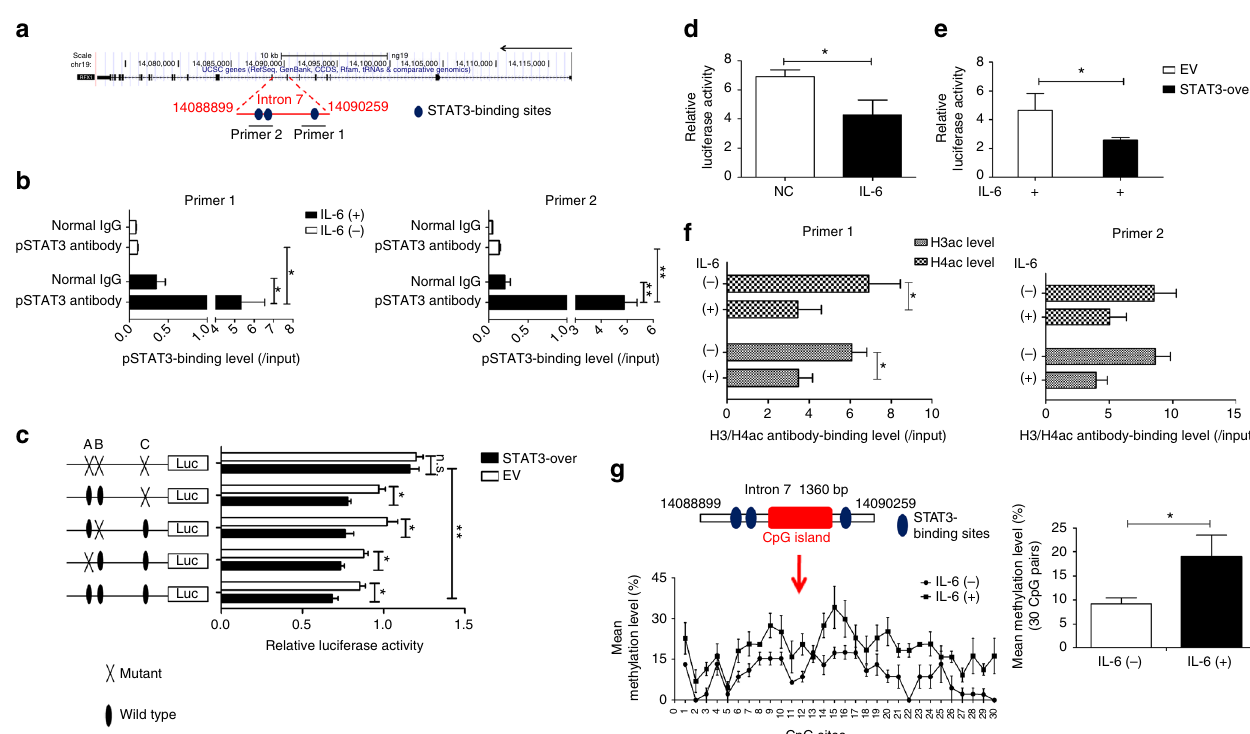
Fig. 9 The IL-6-STAT3 pathway regulates epigenetic modi fi cations of the RFX1 locus. a Genome location of the RFX1 locus and the STAT3-binding sites in intron 7 of the RFX1 gene. b ChIP-qPCR assay of pSTAT3 binding in intron 7 of RFX1 in CD4 + T cells with or without IL-6 stimulation. Primer 1 and Primer 2 were used to amplify the fragment containing STAT3-binding sites. c Luciferase reporter assay analysis of STAT3 regulation on the enhancer activity of intron 7 in 293T cells transfected with STAT3 expression vector (STAT3-over) or empty expression vector (EV). A, B, and C represent the STAT3-binding sites in intron 7. d Luciferase reporter assay analysis of the enhancer activity of intron 7 in CD4 + T cells with IL-6 stimulation and negative control. e Luciferase reporter assay analysis of the enhancer activity of intron 7 in CD4 + T cells with IL-6 stimulation transfected with STAT3 expression vector (STAT3-over) or empty expression vector (EV). f ChIP-qPCR analysis of H3 acetylation level and H4 acetylation level of intron 7 of the RFX1 gene in CD4 + T cells with or without IL-6 stimulation. g BSP analysis of the DNA methylation level of CpG island in intron 7 of the RFX1 gene in CD4 + T cells with or without IL-6 stimulation. The left panel shows the methylation level of each CpG site, and the right panel shows the mean methylation level of all 30 CpG sites in the CpG island. Data are representative of three independent experiments (mean ± s.d.; n = 3). * P < 0.05, ** P < 0.01, compared between the indicated groups. n.s., not signi fi cant. P -values were determined using two-tailed Student ’ s t downregulation of RFX1 contributes to IL-17A overexpression and promotes IL-17A-producing T cell differentiation in SLE patients.